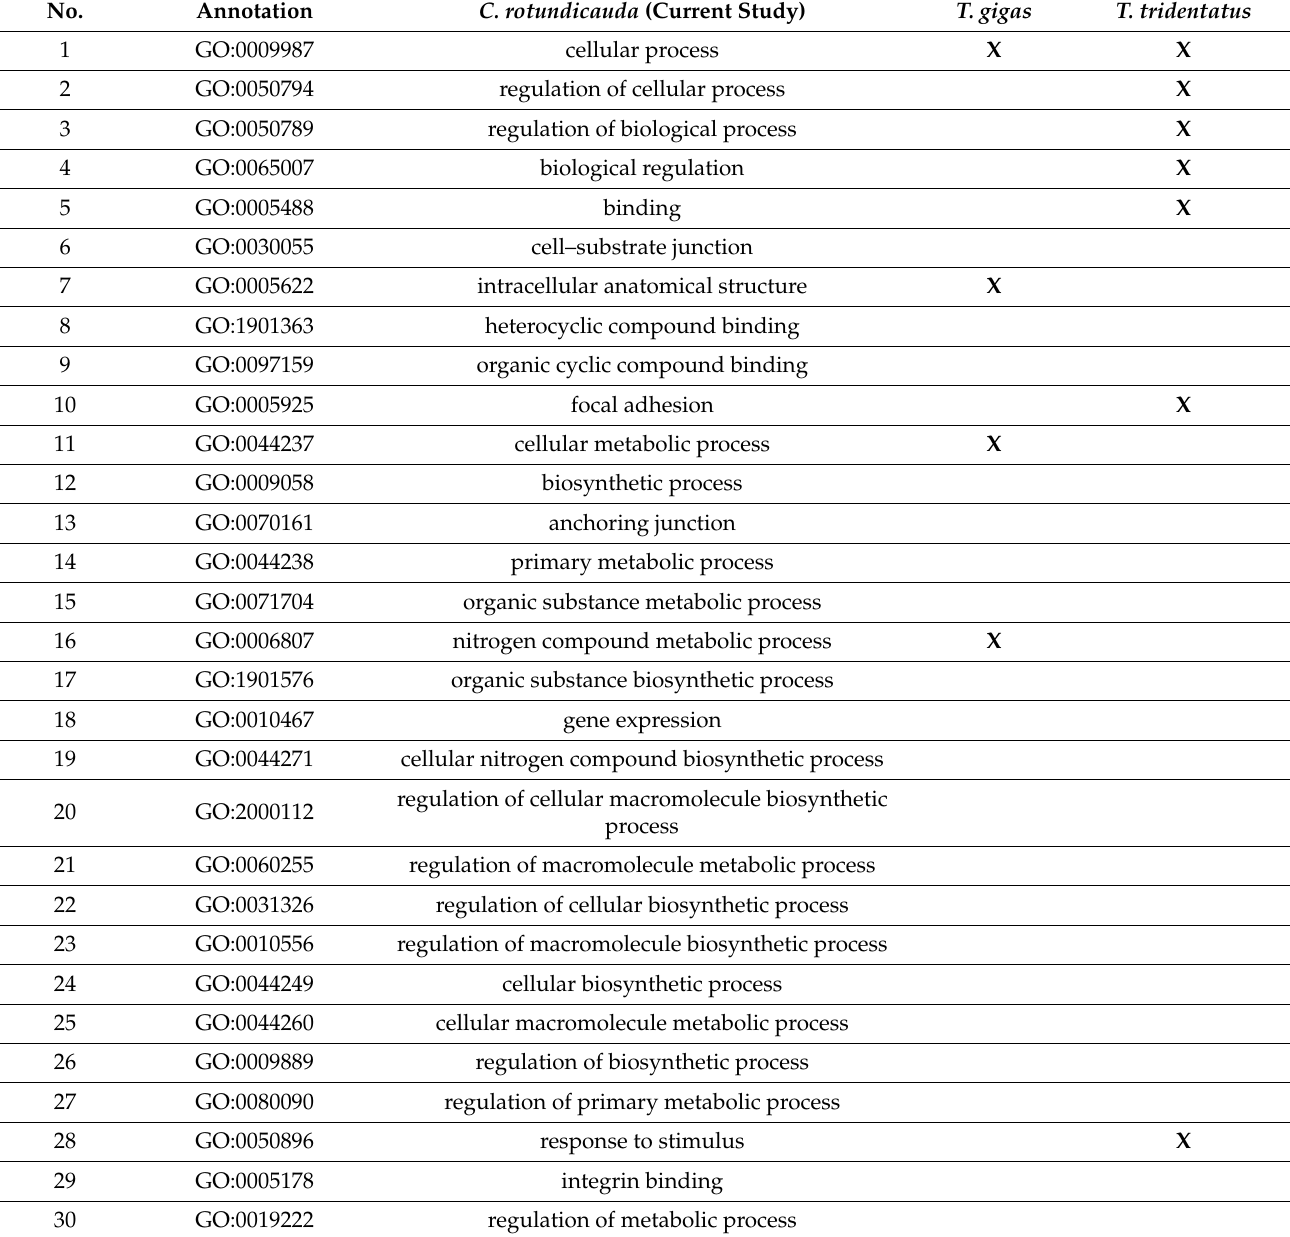
Table 2. The top 30 most enriched gene ontology (GO) terms of C. rotundicauda (current study) differentially expressed genes (DEGs) compared with T. gigas [7] and T. tridentatus